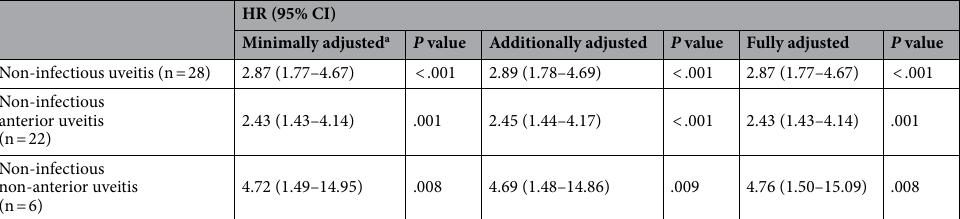
HR (95% CI) Minimally adjusted a P value Additionally adjusted P value Fully adjusted Non-infectious uveitis (n =